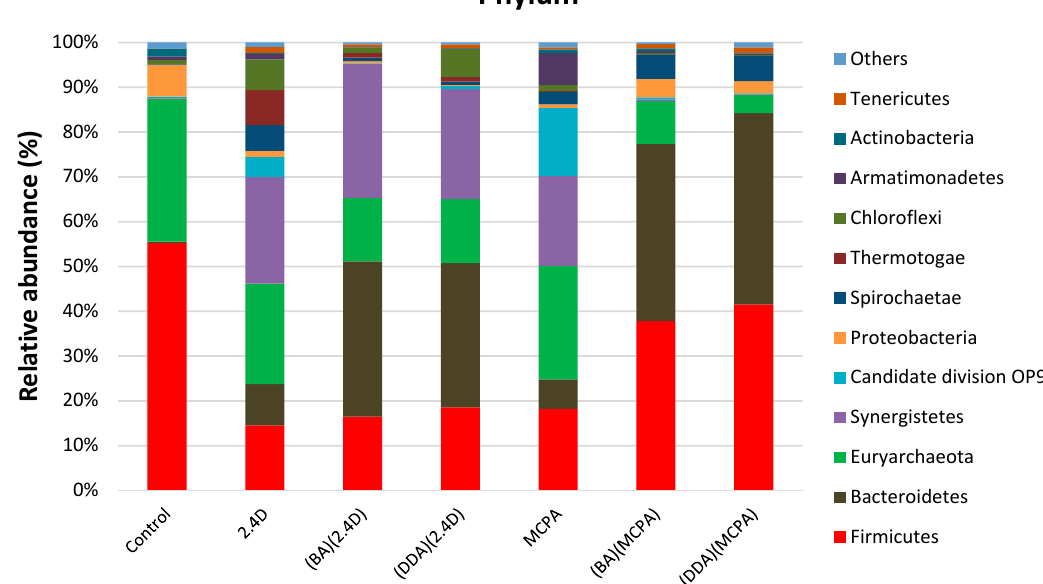
Figure 2. The ratio of Classes and Phyla in the biogas-producing microbial